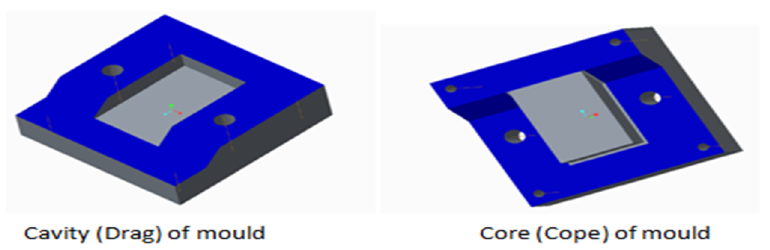
Figure 1. Cavity and core of mould.